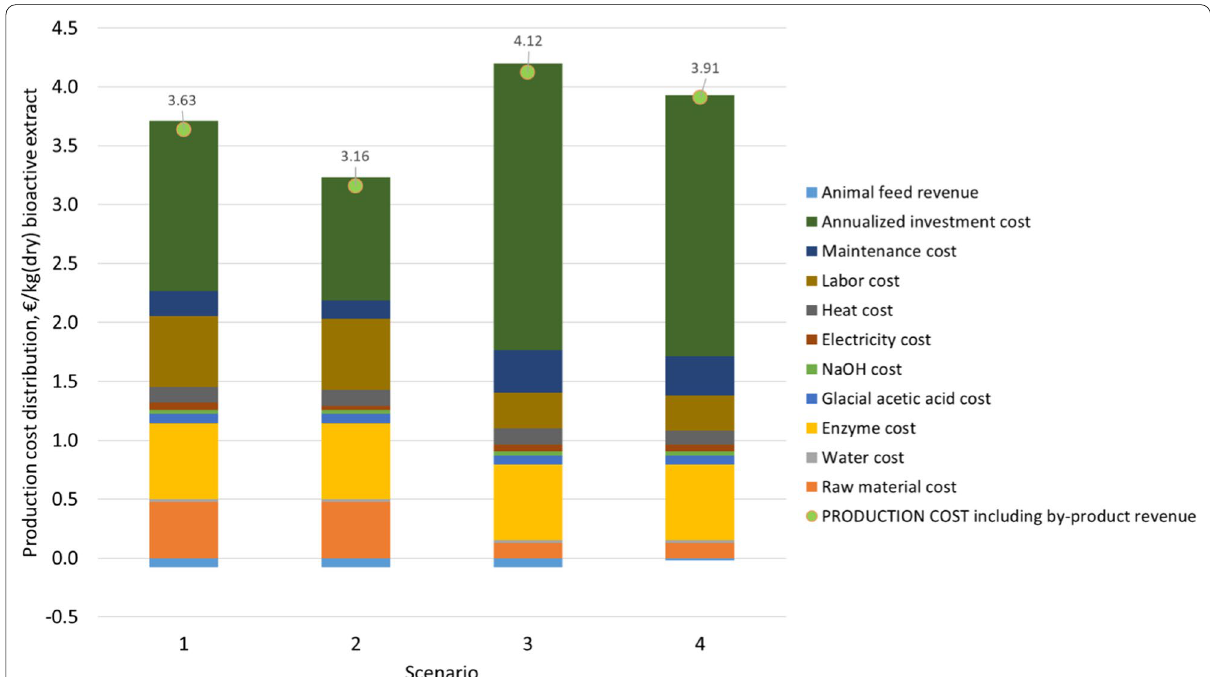
Fig. 4 Production cost distribution in four techno‑economic